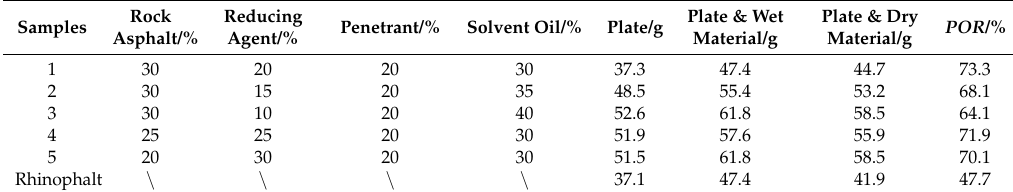
Table 4. POR test results in 5 proportions.